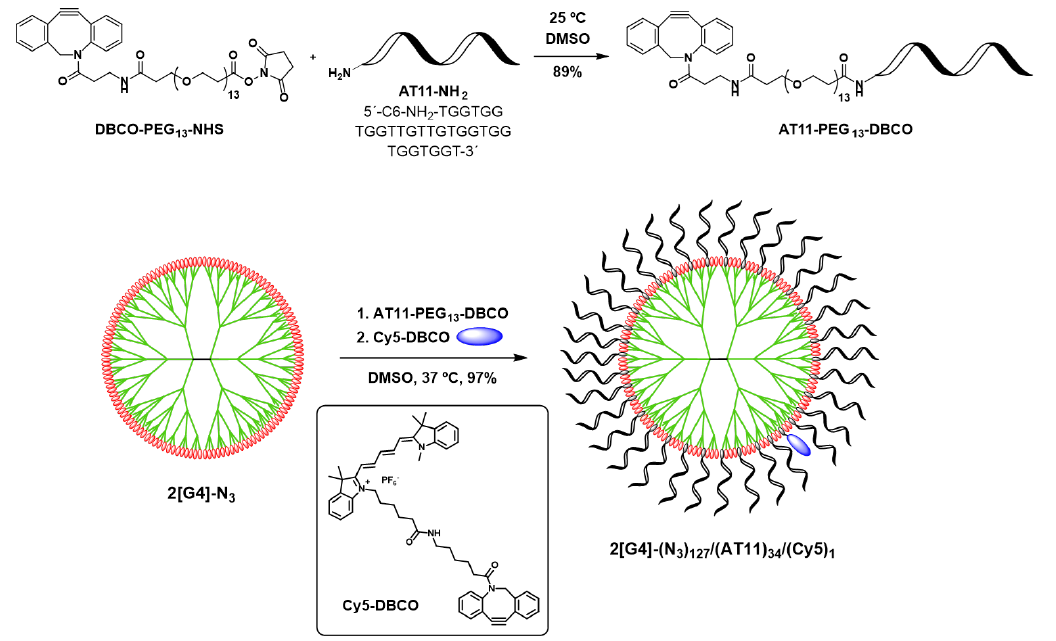
Figure 2. Surface functionalization of 2[G4]-N 3 dendrimer with AT11 aptamer and fluorophore labelling. ( A ) Functionalization of AT11 with a DBCO cyclooctyne and ( B ) AT11 bioconjugation on dendrimer surface by SPAAC.